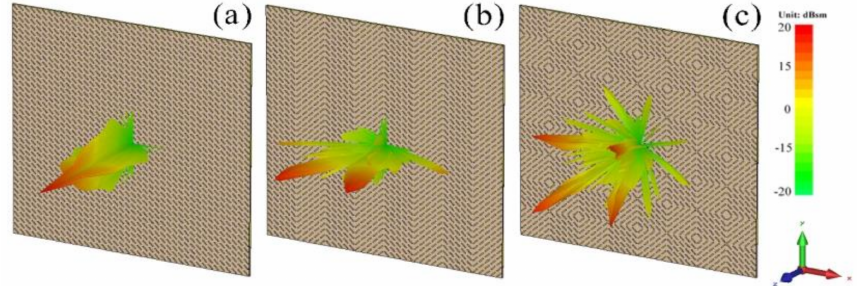
Figure 5. Simulation far-field patterns of the scattering of ( a ) 00/00 or 11/11; ( b ) 01/01 or 10/10; and ( c ) 01/10 at 10 GHz for the coding